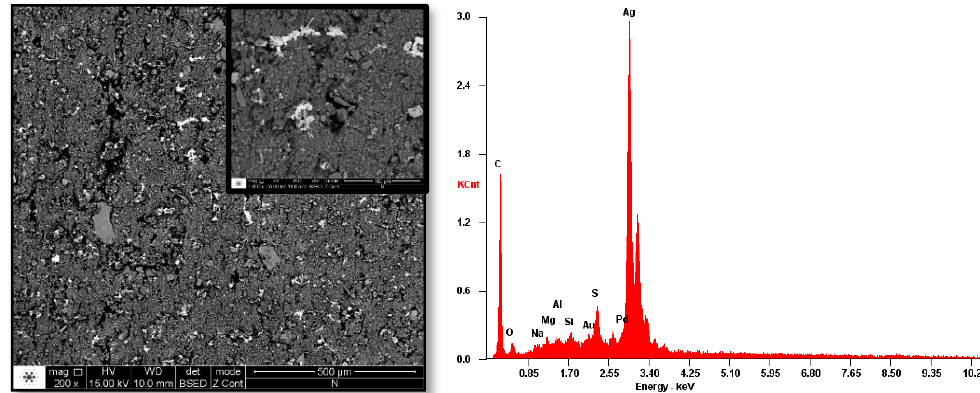
Figure 5. Scanning electron microscopy (SEM) micrographs of a PVP-coated HNBR (PHNBR) sample after silver nitrate activation and energy dispersive X-ray spectroscopy (EDS) analysis. The white specks correspond to nanoparticles of Ag.